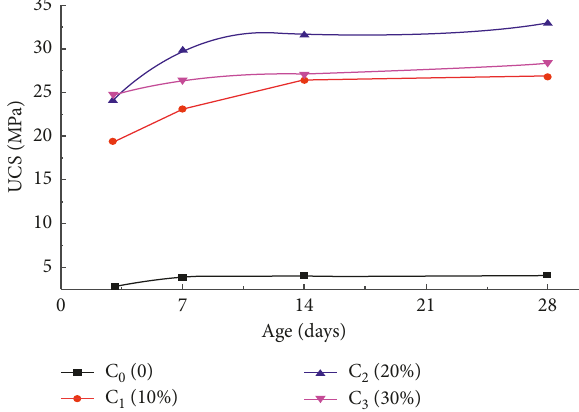
Figure 6: Compressive strength of different CO